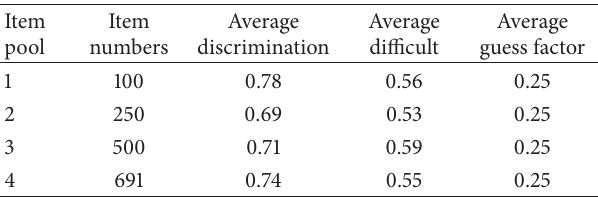
Table 1: Item pools scale and parameters description.